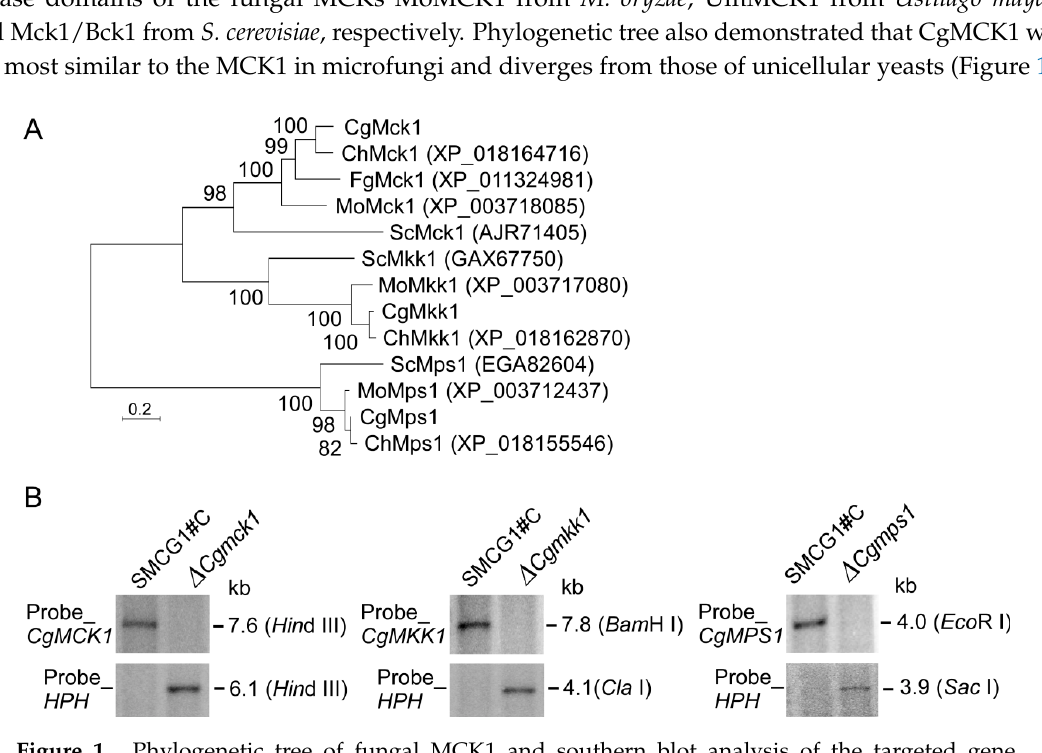
Figure 1. Phylogenetic tree of fungal MCK1 and southern blot analysis of the targeted gene deletion mutants. ( A ) Phylogenetic tree generated using the Mega7.0 program with neighbor-joining method (https://www.megasoftware.net/). ChMck1, ChMkk1 and ChMps1 form Colletotrichum higginsianum . MoMck1, MoMkk1 and MoMps1 from Magnaporthe oryzae . ScMck1, ScMkk1 and ScMps1 from Saccharomyces cerevisiae . FgMck1 from Fusarium graminearum . ( B ) Southern blot analysis of the targeted gene deletion mutants.